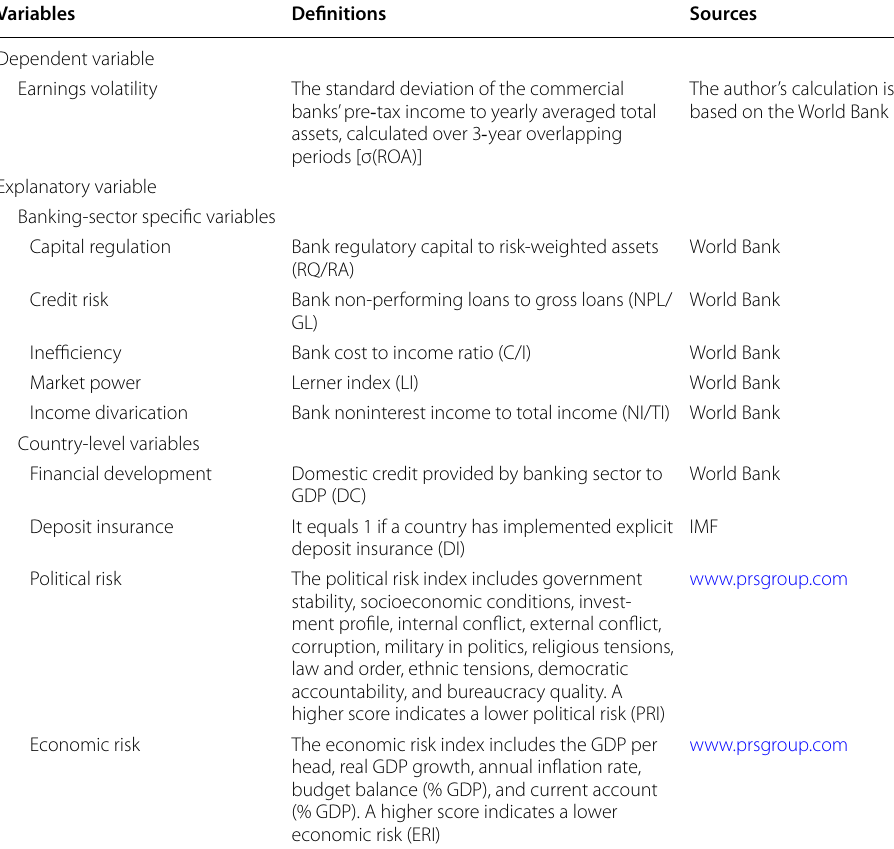
This table shows the definitions and sources of variables that are used in the econometric model. As shown, the data for the banking-sector-specific variables were collected from World Bank. Likewise, the data for country-level variables were collected from various sources including World Bank, IMF, and PRS